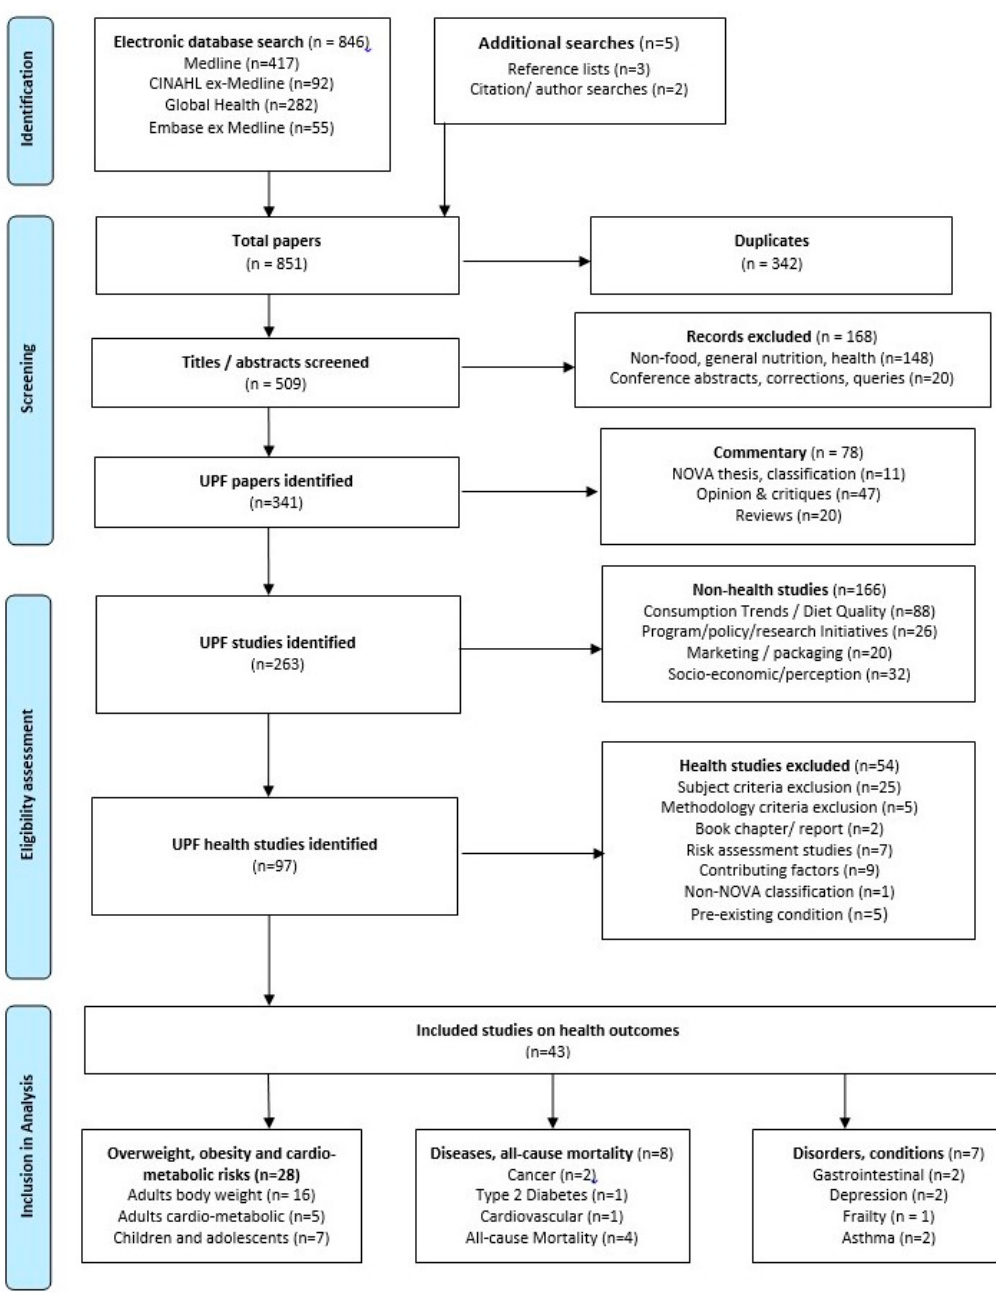
Figure 1. Flow Diagram of Database Search and Article Eligibility (modified from PRISMA flow diagram [43,44] ).